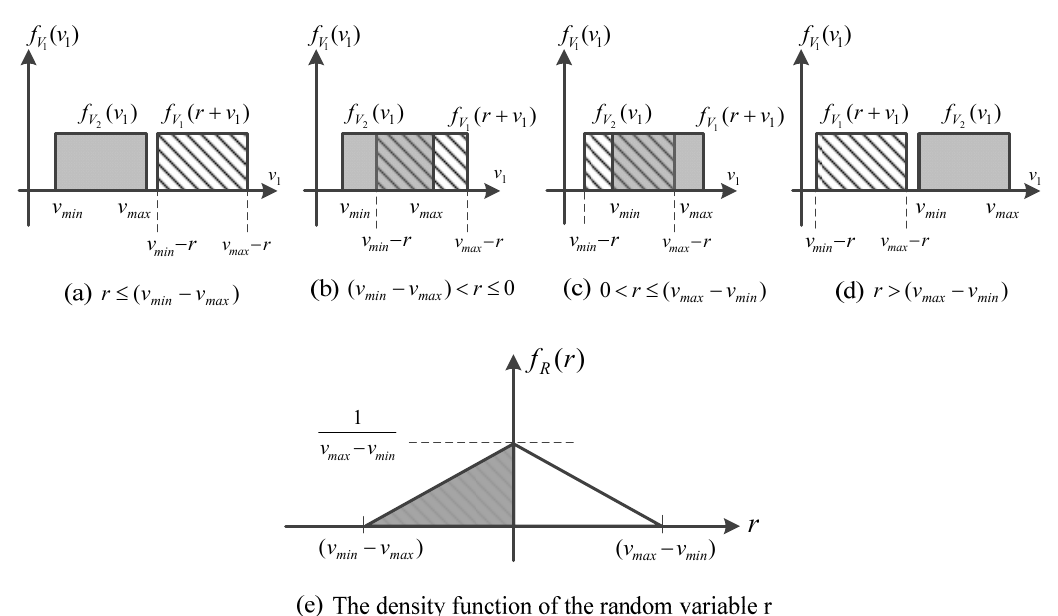
Figure A2. Derivation of the density function of the relative velocity r